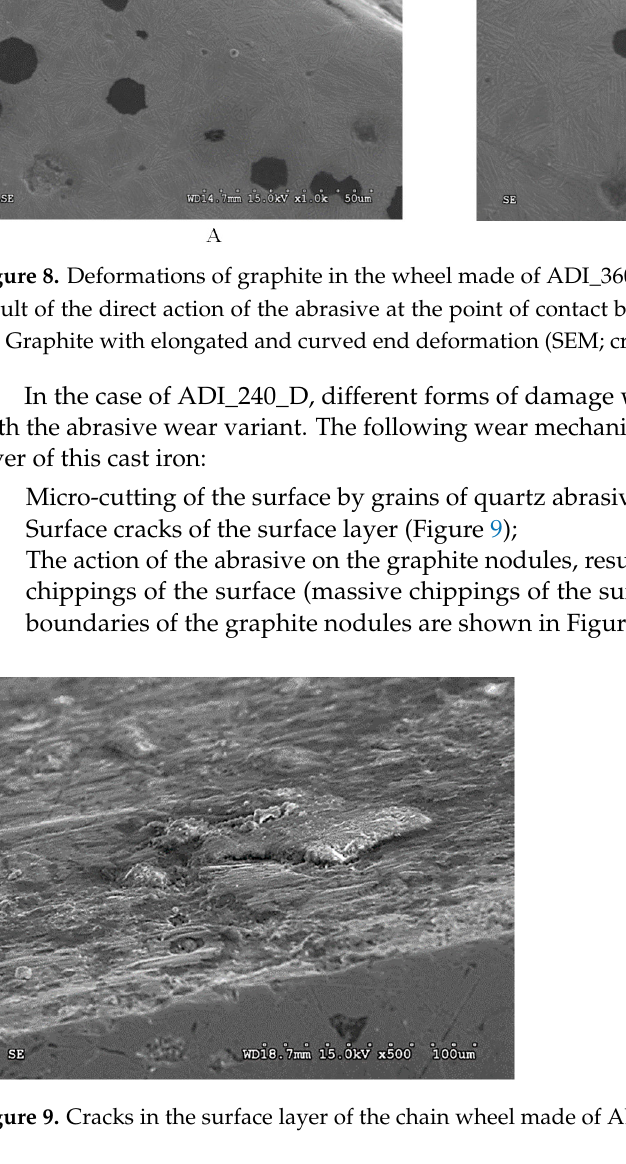
Figure 10. Chippings in the layer running along the boundaries of graphite nodules (ADI_240_D) (SEM; cross-section). The last form of damage causes the largest cavities in the surface layer and may result from earlier cracks in the surface (such as in Figure 11) initiated by the action of dynamic forces. ADI_240 showed the highest susceptibility to the synergistic action of dynamic forces, which can be explained by the fact that ADI samples austempered at lower tem- peratures have the lowest resistance to cracking. Figure 11 shows a comparison of the wear parameter δ i_AVG in a function of the posi- tion in the measuring path (further in the paper this parameter will be denoted as δ i_AVG (i)), obtained for the abrasive wear variant and the abrasive-dynamic wear variant of all the grades of tested ADI.